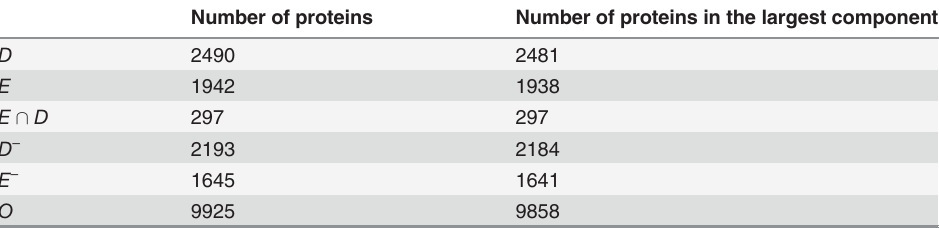
Table 2. Statistics of the proteins in the protein interaction network constructed based on the i2d database.